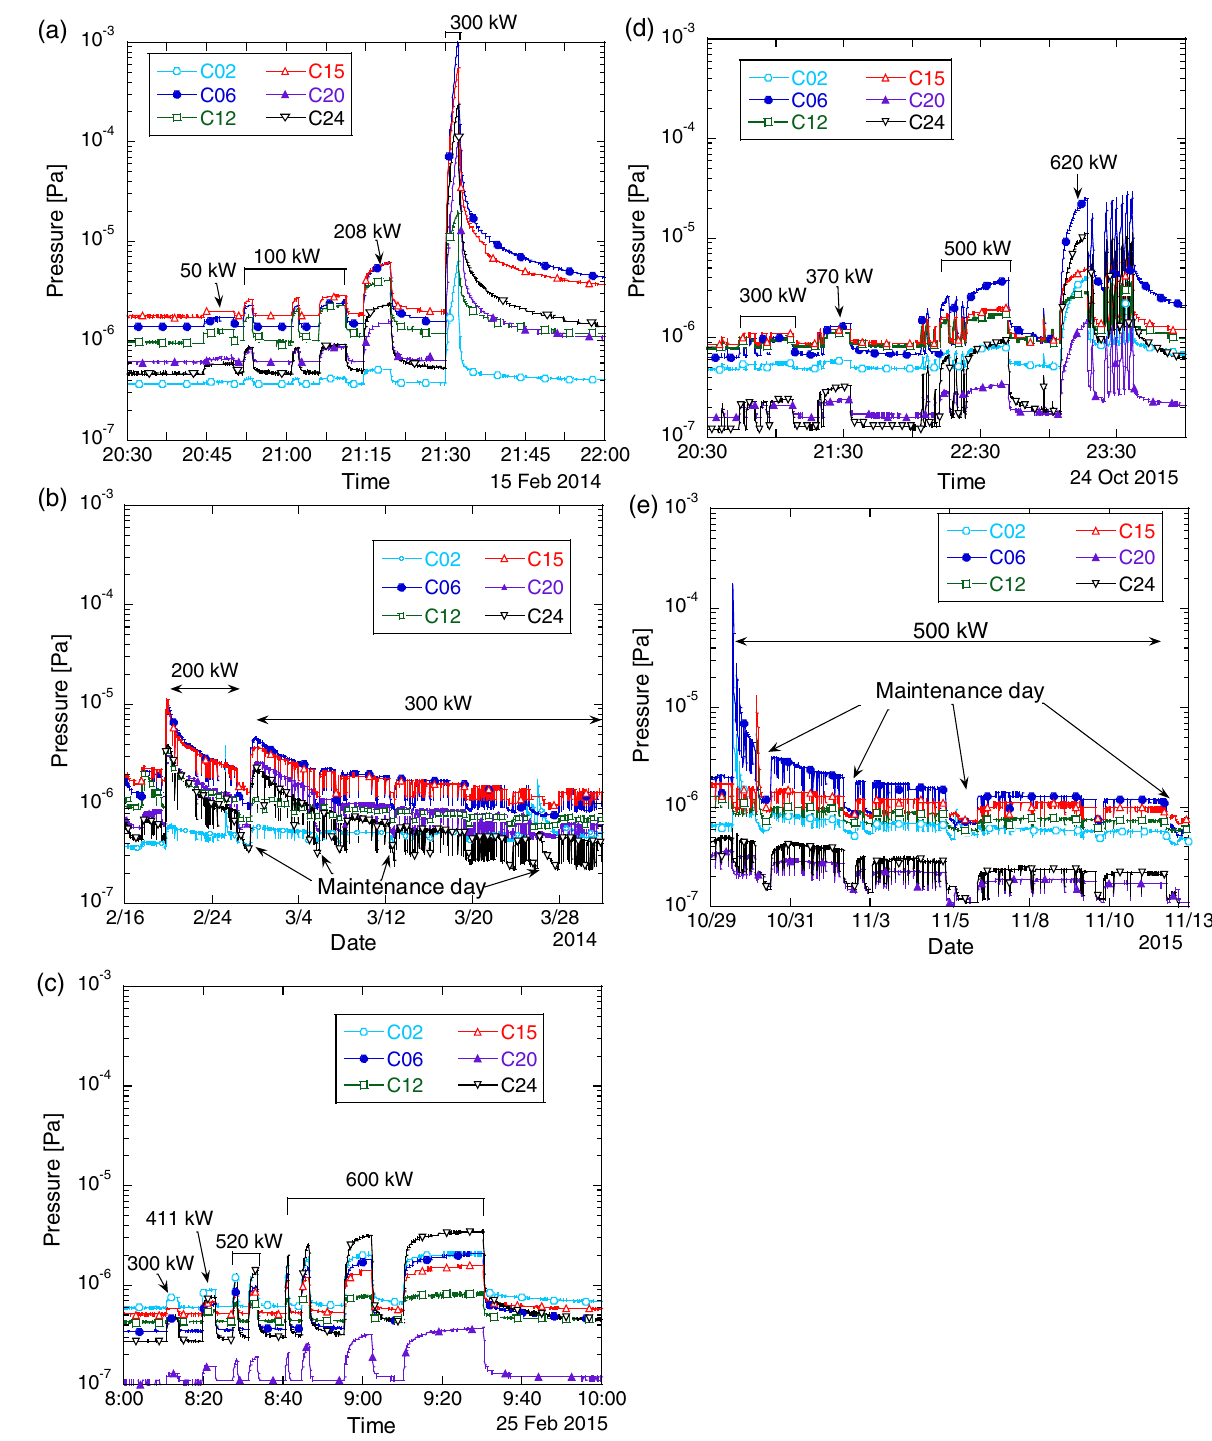
FIG. 15. Beamlinepressureduringthehigh-powerbeamoperation.Panels(a)to(e)correspondtothebeamlinepressureinpointsAtoEin Fig. 14, respectively. The pressure measured by the representative CCGs in each section is plotted. C02: Injection section, C06: first arc section, C12: Extraction section, C15: second arc section, C20: RF section, and C24: third arc section. (a) (Point A) Pressure in the beam commissioning after position alignment work of the beam line equipment. The beam lines in all sections have been purged by argon gas and opened to air during the work. (b) (Point B) pressure during the user operation at the 200 – 300 kW beam power after point A. (c) (Point C) pressureinthebeamcommissioningaftersuspensionofthebeamoperation.ThebeamlinehasbeenkepttobeevacuatedbytheTMPsduring the suspension. (d) (Point D) pressure in the beam commissioning after vacuum system shutdown for maintenance. A few flanges in some sections have been opened to air for a short time. (e) (Point E) pressure during the user operation at the 500 kW beam power after point